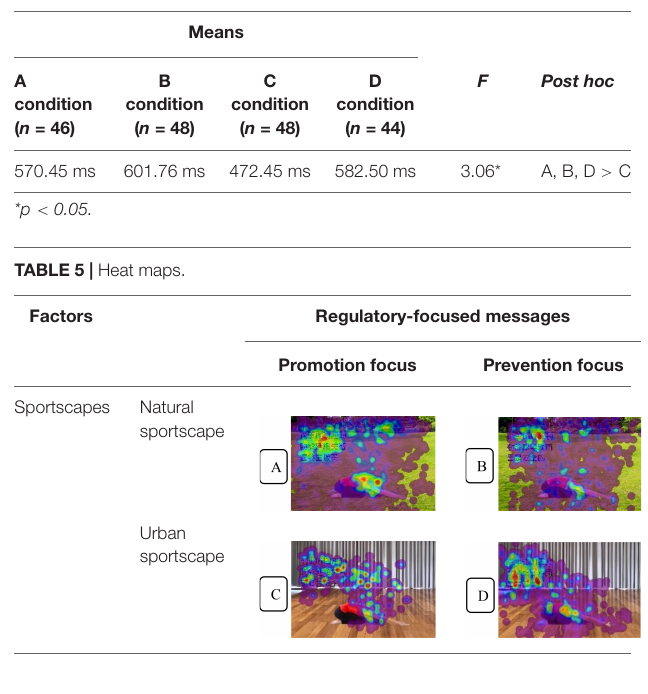
TABLE 4 | The average fixation duration (ms) of eye movement performance under the four conditions.